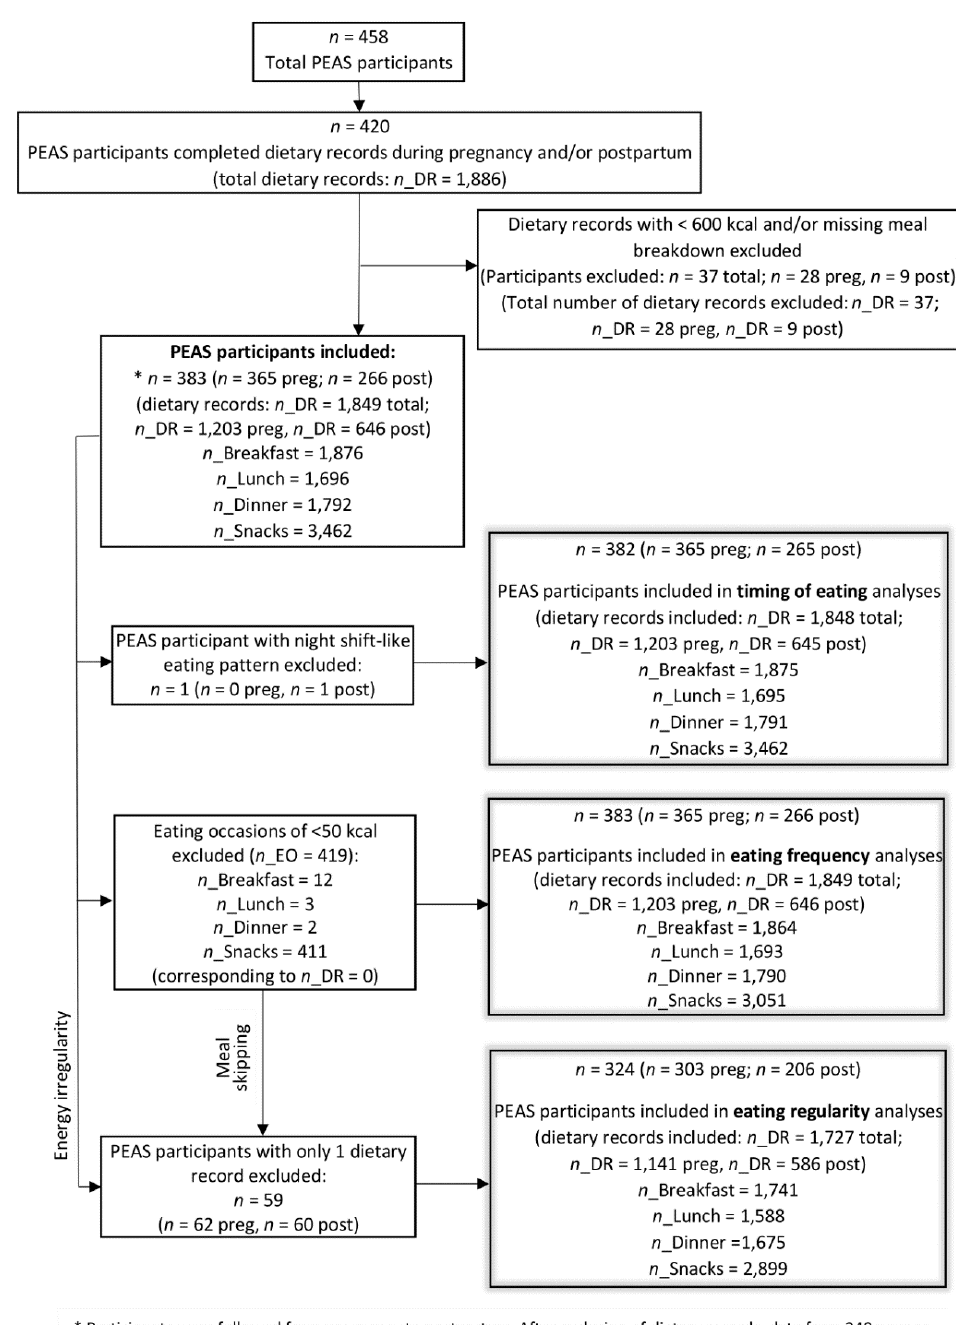
Figure 2. Flow diagram of PEAS participants for analysis in the present study. n , number of participants; n _DR, number of dietary records; n _EO, number of eating occasions; preg, participants in pregnancy; post, participants in postpartum.